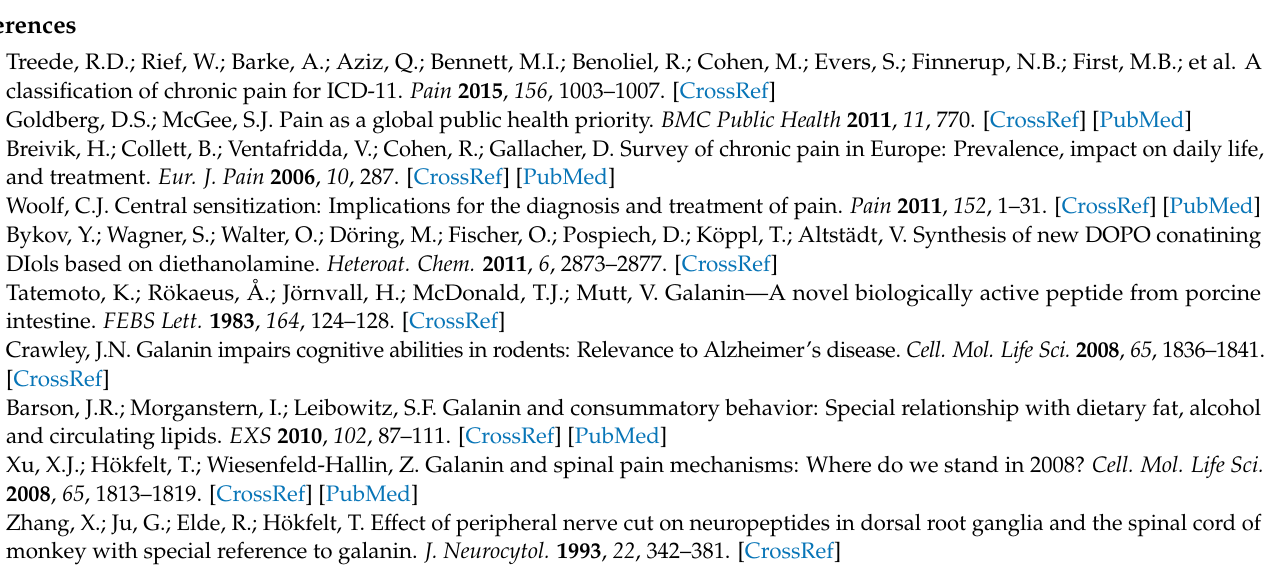
Table S2: Summary of the literature search on the role of galanin and its receptors in the processing of nociceptive information; Table S3: Summary of the literature search on the role of galanin and its receptors in different animal models of chronic